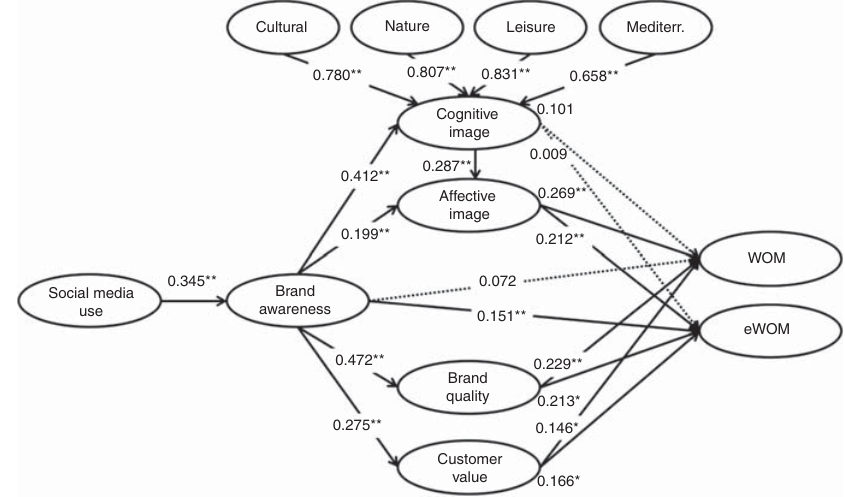
Figure 2. Conceptual model